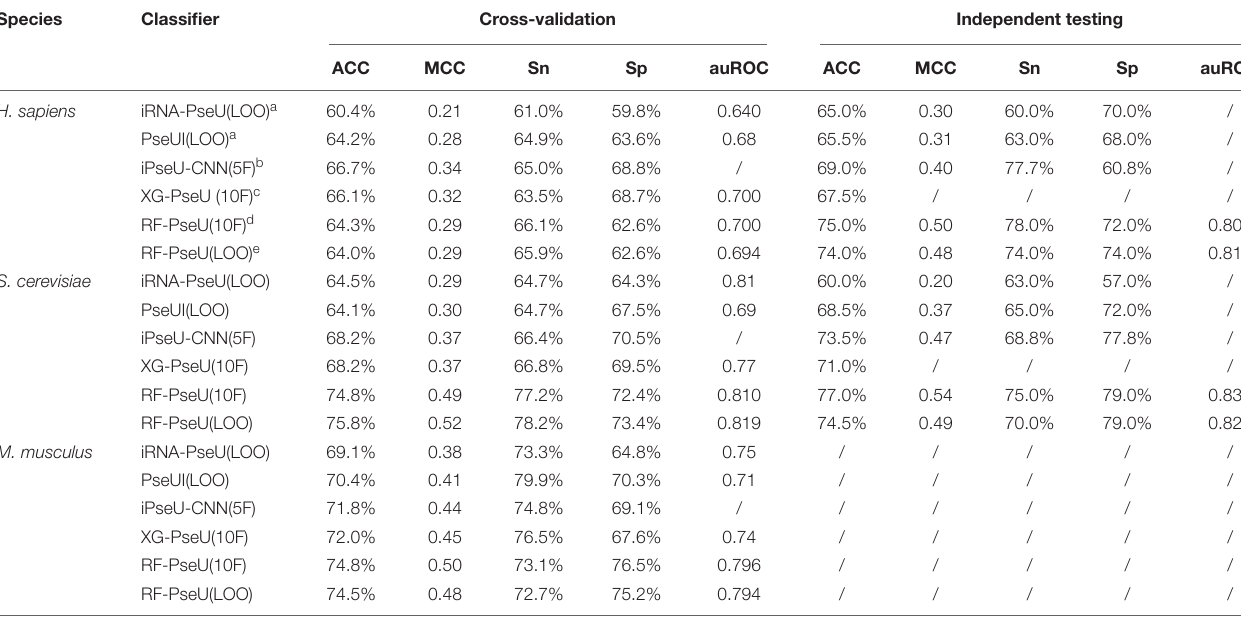
TABLE 3 | Comparison of cross-validation and independent testing scores of existing state-of-the-art pseudouridine site predictors and RF-PseU. Species Classifier